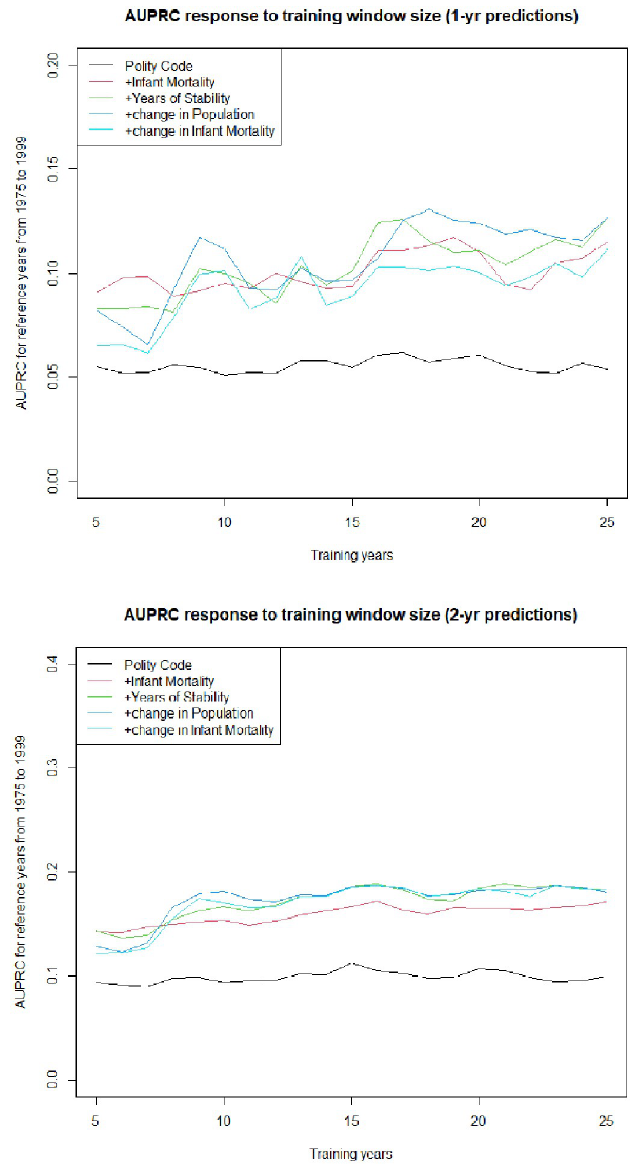
Fig 2. Response to training window size. Building up a 5-parameter model, one variable at a time, to predict instability one and two years in advance.